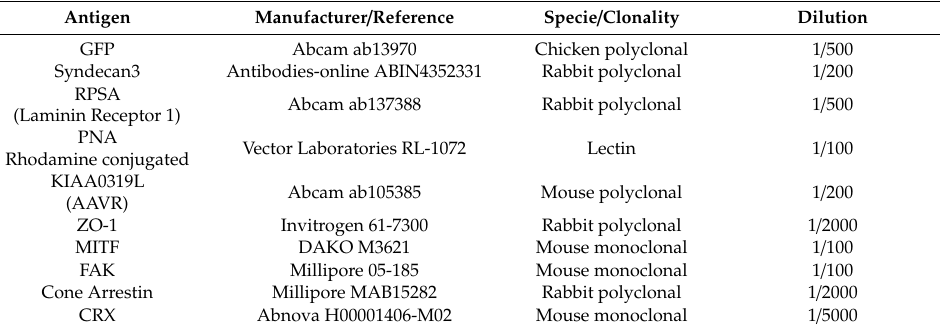
Table 2. Primary Antibodies and Lectins.